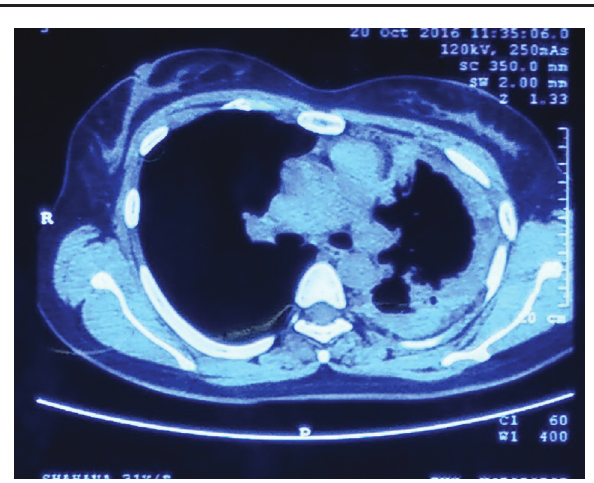
The evaluation of her chest radiograph showed blunting of the right costophrenic angle with normal lung parenchyma. Ultrasonography (USG) chest showed